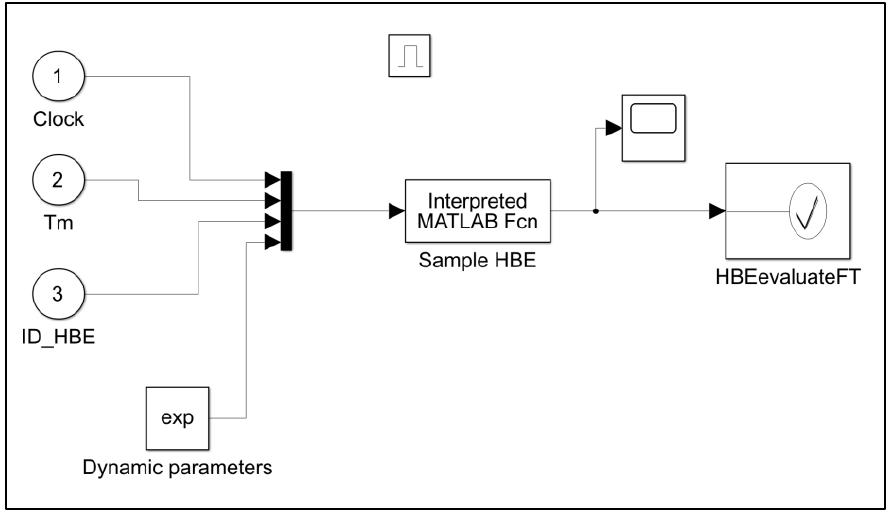
Figure A5. The Simulink implementation of the “Generic Hybrid Basic Event” block.